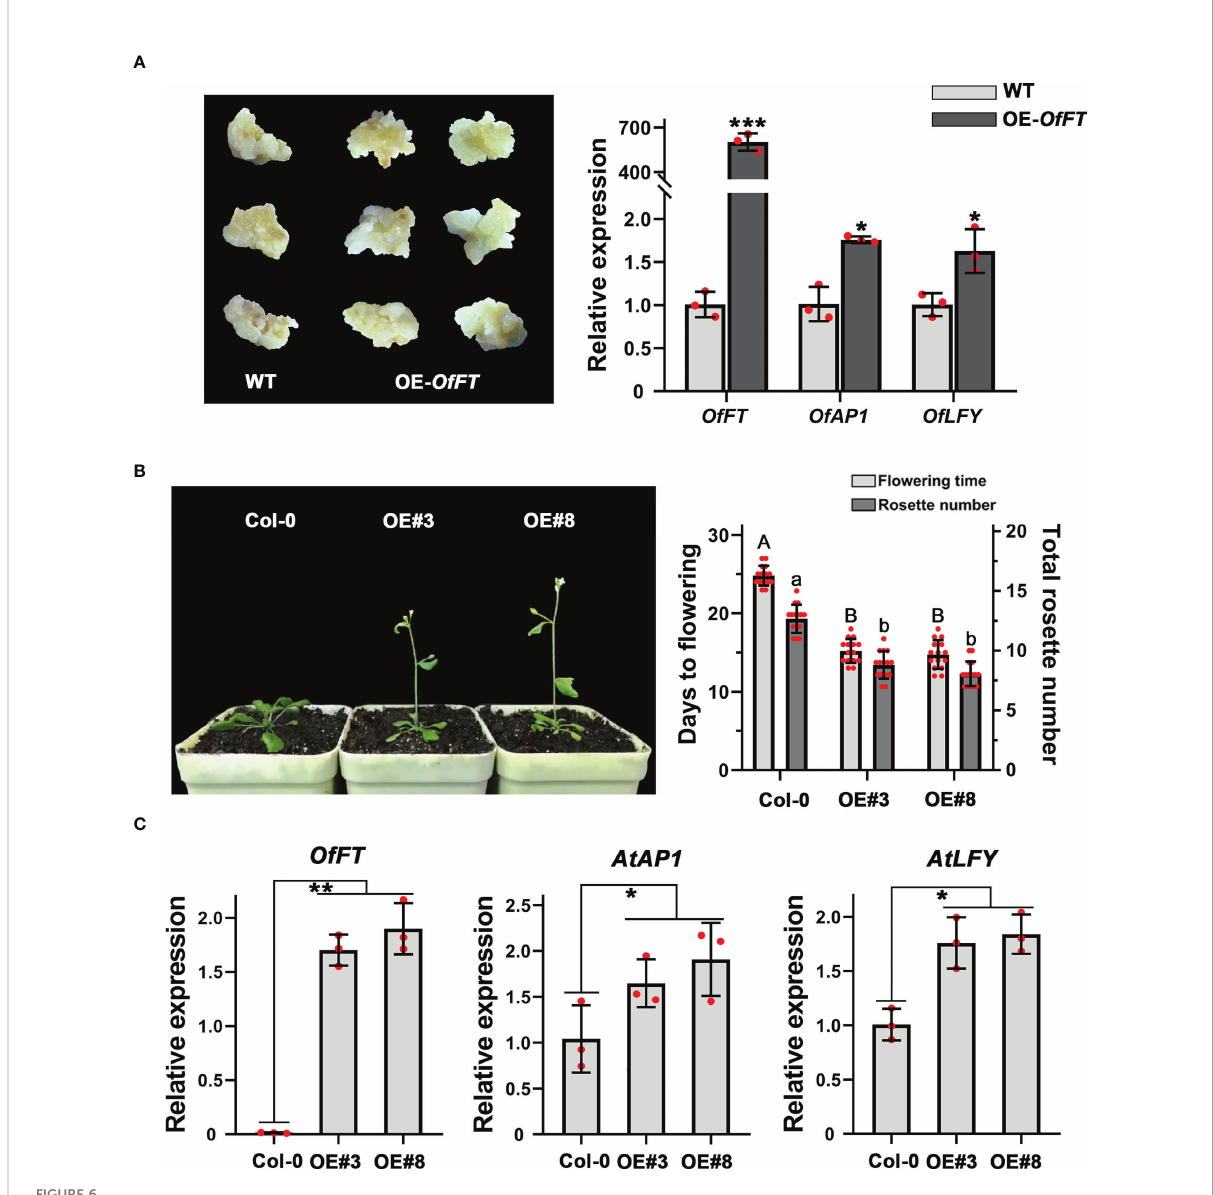
FIGURE 6 OfFT functioned as a fl owering activator in both O. fragrans and Arabidopsis . (A) The expression levels of fl owering-related genes in overexpression ‘ Sijigui ’ callus. Data were the means ±SD, n = 3, Student ’ s t test, * p < 0.05 and *** p < 0.001. (B) Phenotypic analyses of transgenic Arabidopsis plants overexpressing OfFT . Uppercase letters represent signi fi cance of fl owering time compared with mock-treated control. Lowercase letters represent signi fi cance of rosette number compared with mock-treated control. Means ± SD, n = 3, * p < 0.05, ** p < 0.01. For Figure 6: (C) The expression levels of fl owering-related genes in transgenic plants. Means ±SD, n = 3. * p < 0.05, ** p <